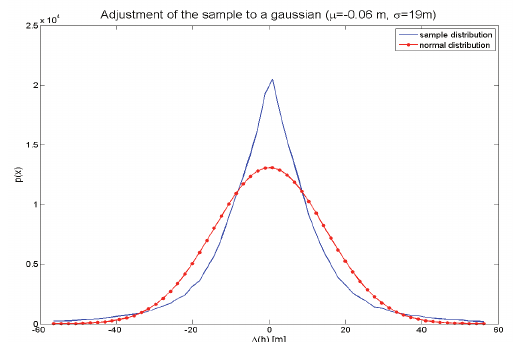
Figure 1. Histogram of the height differences (Switzerland- Lombardy DTMs) compared with Gaussian distribution with the same standard deviation.